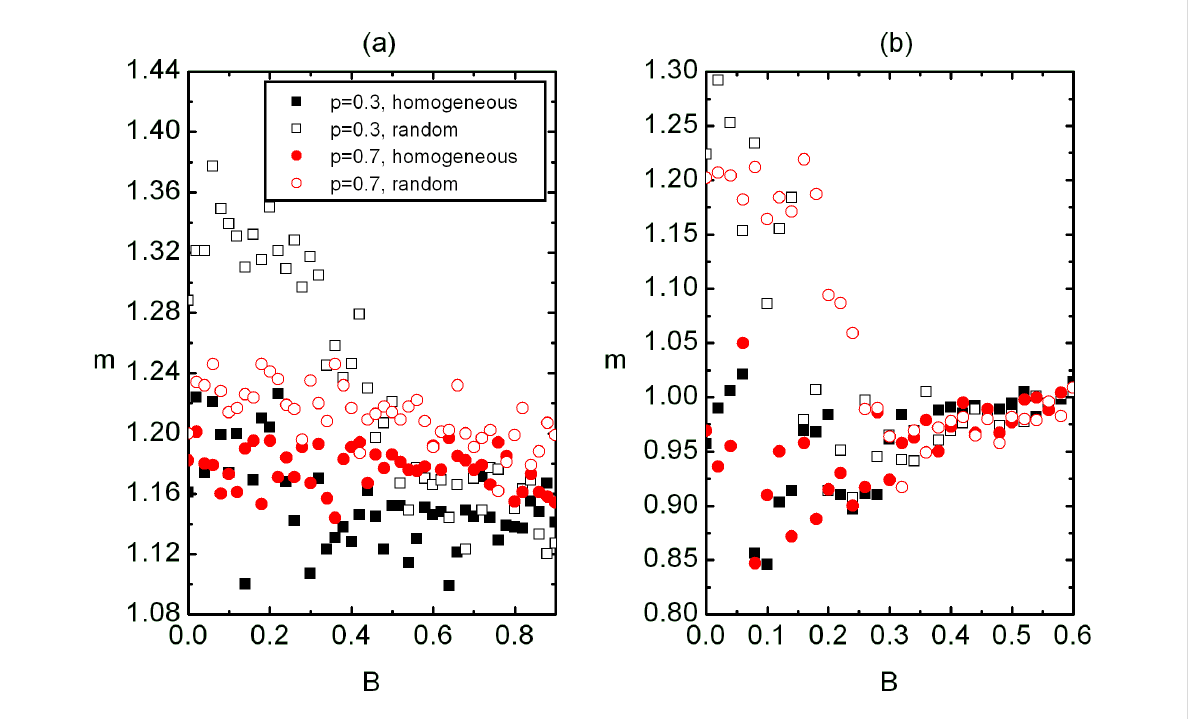
Figure 4: The m ( B ) dependence r homogeneous and random samples for two different p in (a) 2D and (b) 3D. In the disordered regime it holds m (ran) > m (hom) > 1. In the ordered regime we obtain m (ran) ≈ m (hom) > 1 which asymptotically approach one on increasing B . (a) W = 2.5, N 0 = 260; (b) W = 2.5, N 0 = 100. The legend is shown in (a).